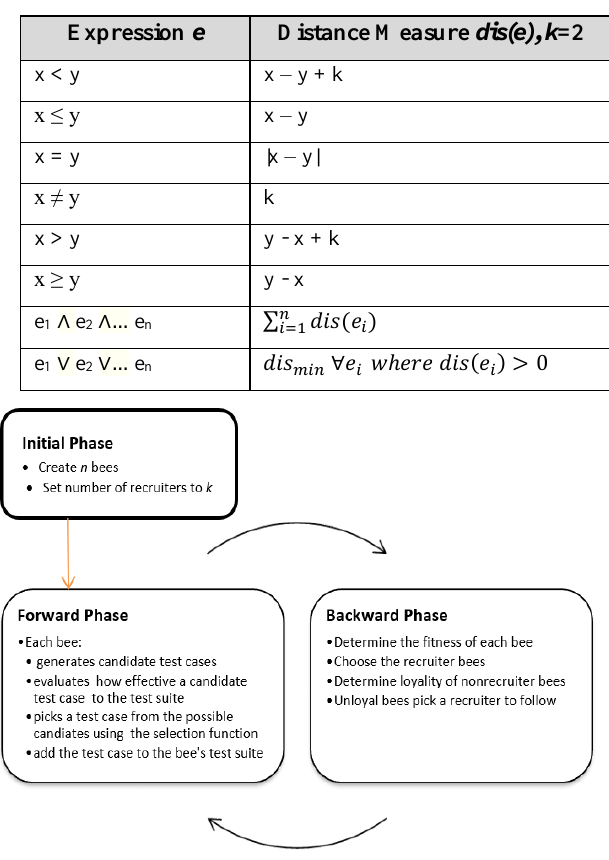
Figure 1. The general process of our BCO